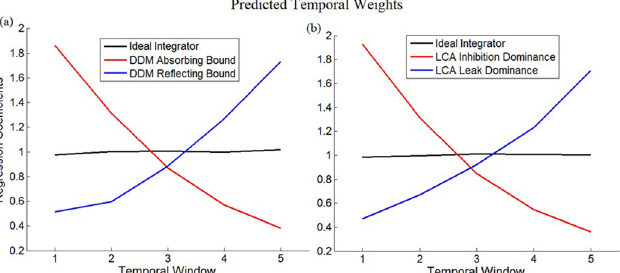
Fig 2. Simulation of typical temporal weighting profiles predicted by the drift-diffusion model (DDM) and leaky-competing accumulators model (LCA). A) DDM simulations with absorbing bound (red line; parameters: noise = 1; boundary = 2) and reflecting bound (blue line; parameters: noise = 1; boundary = 3) as compared to ideal integration (black line; parameters: noise = 1; response was determined by comparing the value of the accumulator to 0). Both models predict weighs that are flat, monotonically decreasing (a primacy bias; bounded diffusion) or monotonically increasing (a recency bias; reflecting boundaries) temporal weights; B) LCA simulations of temporal weights with inhibition dominance (red line; parameters: noise = 1; inhibition = 0.2; leak = 0) and leak dominance (blue line; parameters: noise = 1; inhibition = 0; leak = 0.1) as compared to ideal integration (black line). Y-axis depicts normalized regression coefficients. Inputs to the models were taken from the experiments; responses of each model were simulated for all trials and were subjected to a logistic regression analysis using the inputs as predictors. We iterated this analysis 1000 times per each model and show here average values of the regression coefficients across these 1000